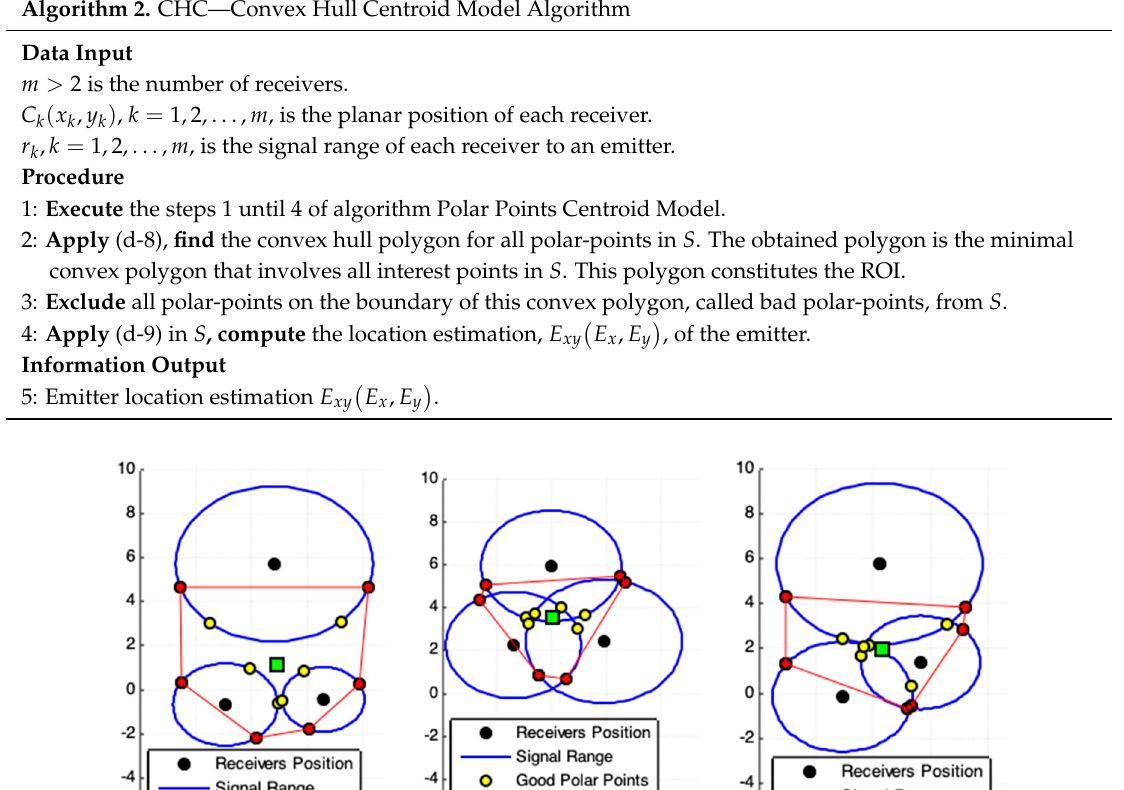
Algorithm 2. CHC—Convex Hull Centroid Model Algorithm